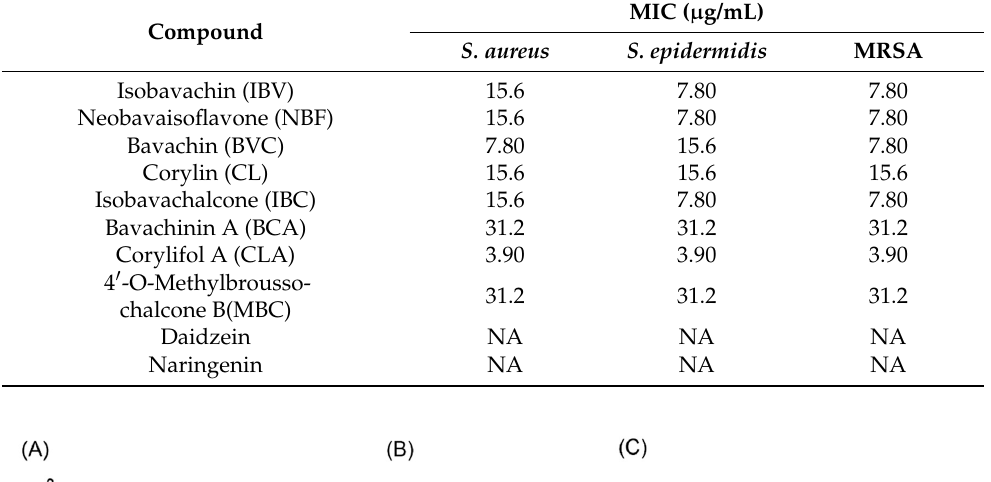
Table 4. The MIC of IPFs and non-prenylated flavonoids against common Gram-positive bacteria. Compound